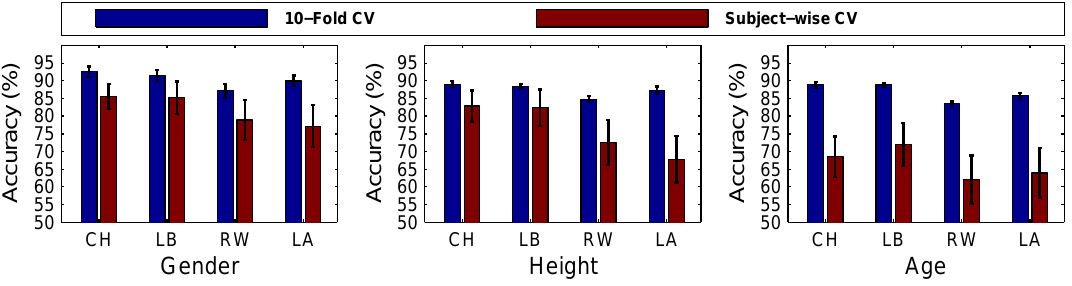
Figure 9. A comparison of correct classification accuracy of group classification tasks (gender, height and age) using 10-fold cross-validation and subject-wise cross-validation. Sensor positions include: chest (CH), lower back (LB), right wrist (RW) and left ankle (LA). The 10-fold cross-validation model outperforms the subject-wise cross-validation model in all